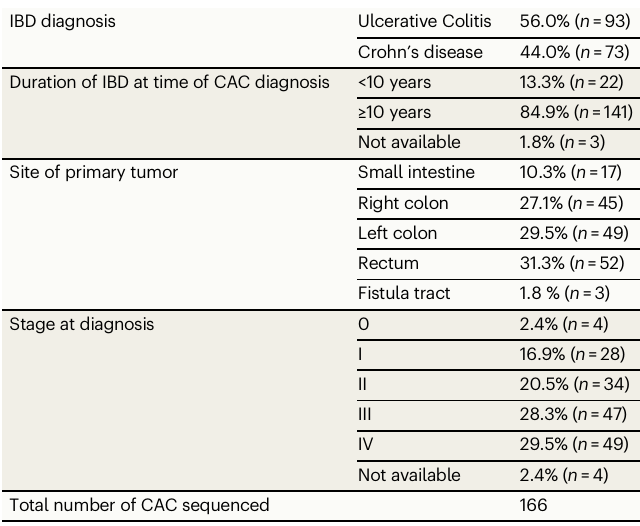
Table 1 | Clinical characteristics of sequenced colitis-asso- ciated cancer cases